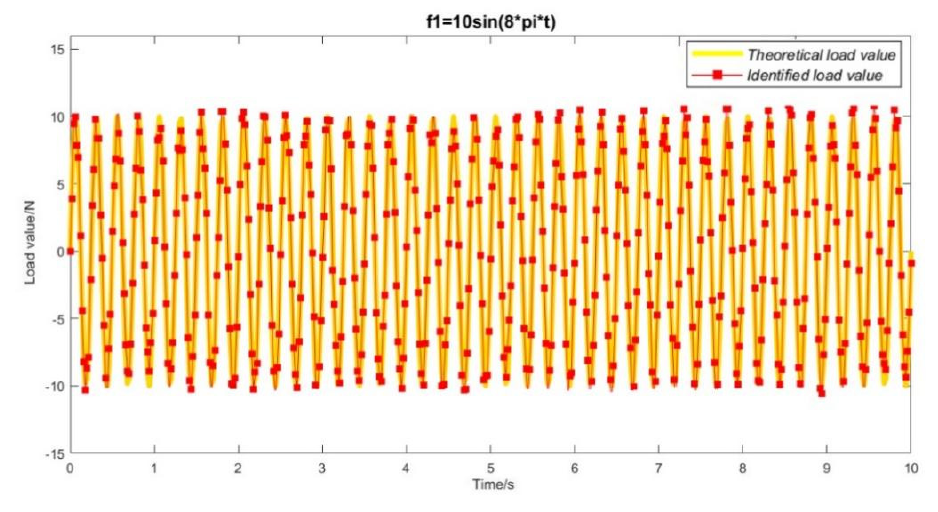
Figure 8. f 1 load-identification results.